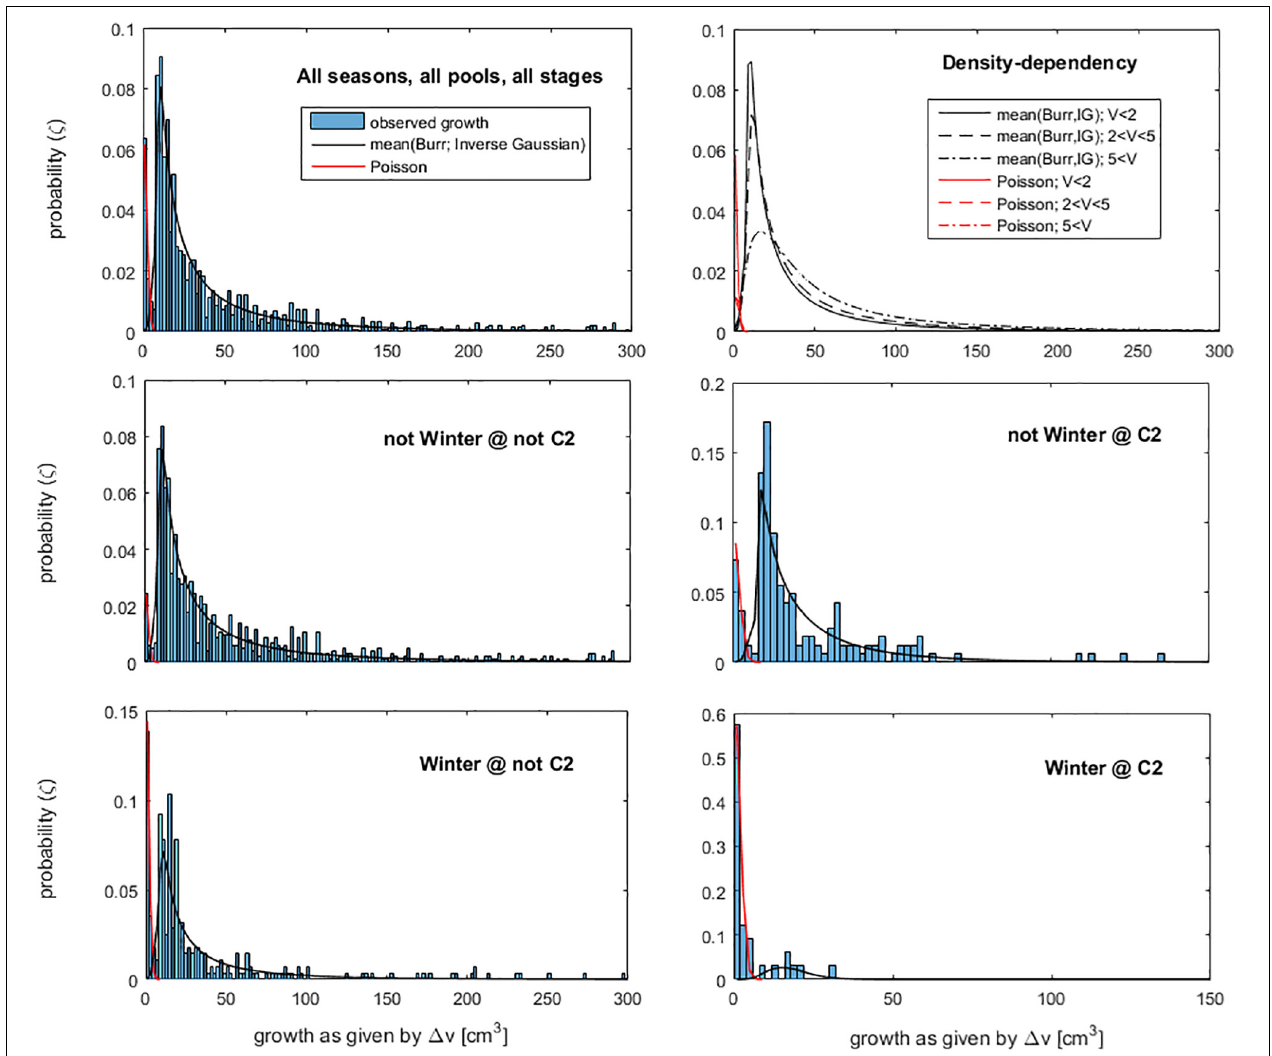
FIGURE 2 | Probability density functions (PDF) of the growth ( (cid:49) v) of the bare holdfasts. The probability was named ‘ ζ ’ to avoid confusion with another use of the letter p in this same section. Each panel is the PDF of (cid:49) v given the conditions specified in the panel tittle. The surviving bare holdfasts growing less than 6 cm 3 were fit by the Poisson distribution. The surviving bare holdfasts growing more than 6 cm 3 were fit by the mean of the Burr and Inverse-Gaussian distributions. For density-dependency effects, the PDF of (cid:49) w depends on the density of frond volumes (V) on the respective